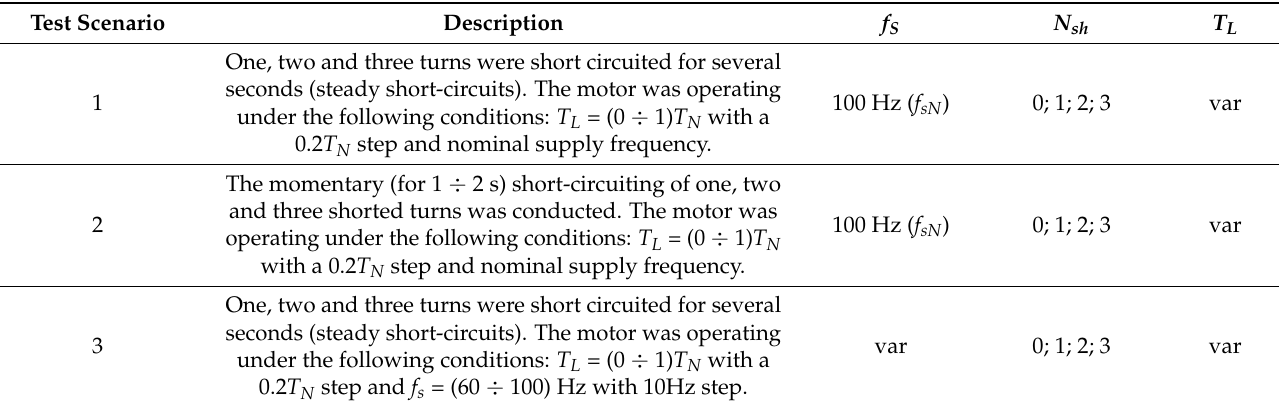
Table 4. Details of the test scenarios.